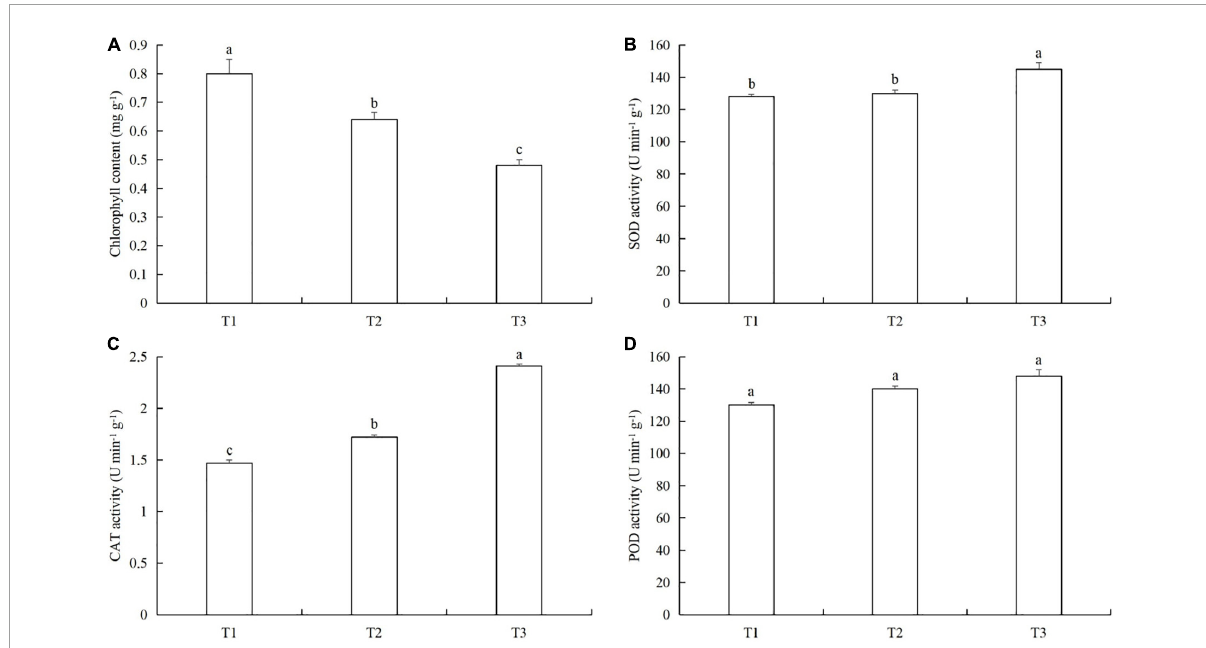
FIGURE7 The effects of timing and order of powdery mildew infection and aphid colonization on (A) chlorophyll content and the activities of (B) superoxide dismutase (SOD), (C) catalase (CAT), and (D) peroxidase (POD) in cucumber leaves. T1, Powdery mildew followed by aphids. T2, Simultaneous powdery mildew infection and aphid colonization. T3, Aphid colonization followed by powdery mildew infection. The mean value ± p < 0.05 error bar data were presented in the figure and different alphabetical letters indicate the significant differences between the different time treatments.